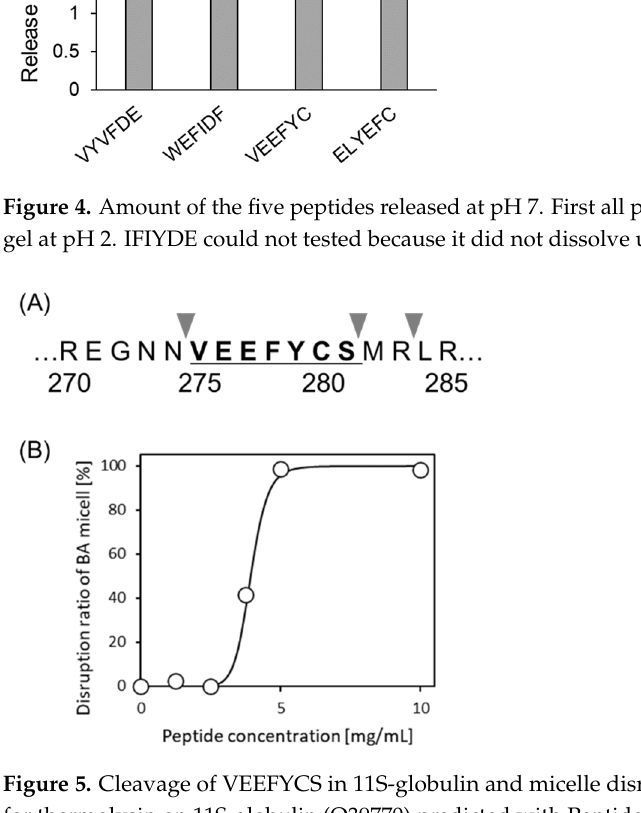
Figure 5. Cleavage of VEEFYCS in 11S-globulin and micelle disruption activity. ( A ) Cleavage sites for thermolysin on 11S-globulin (Q39770) predicted with PeptideCutter. ( B ) Dose-response curve of VEEFYCS in micelle disruption activity.